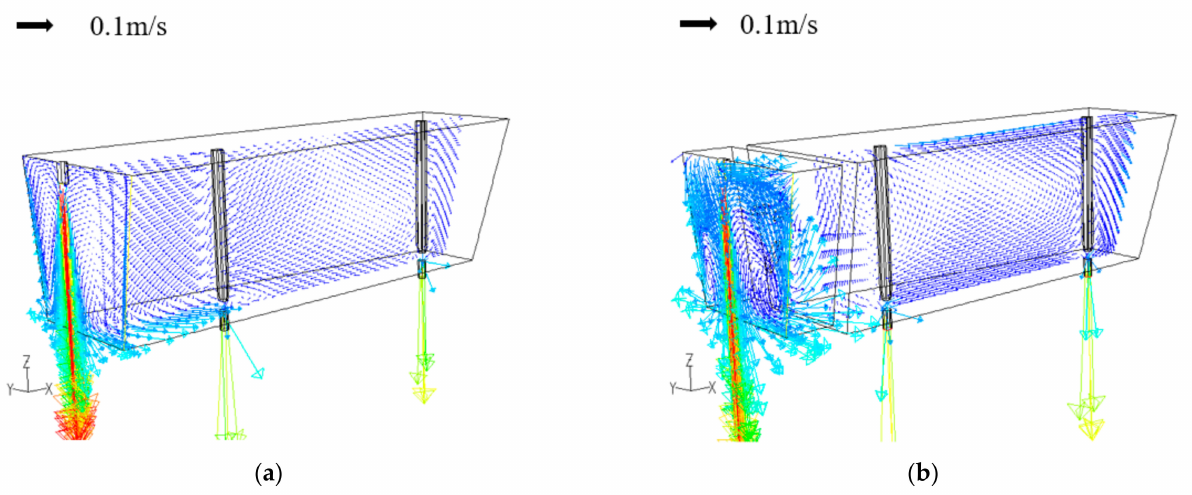
Figure 5. The velocity field with and without FCDs in the tundish. ( a ) Without FCDs; ( b ) with optimized